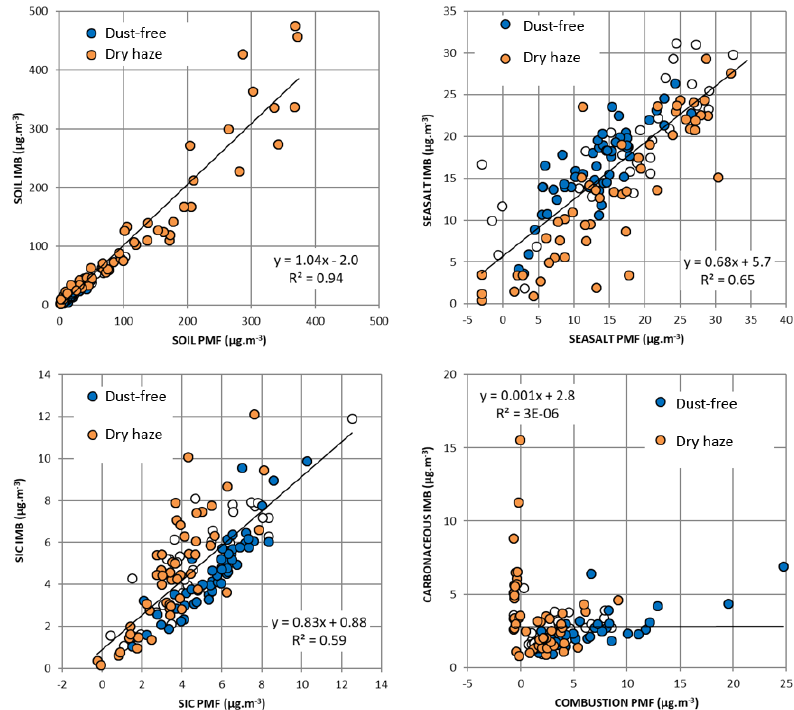
Figure 7. Comparison between the apportionment of individual samples using IMB and PMF for four source classes. Circles filled in white represent periods with intermittent dust intrusions. Linear best fits are presented for the total sampling